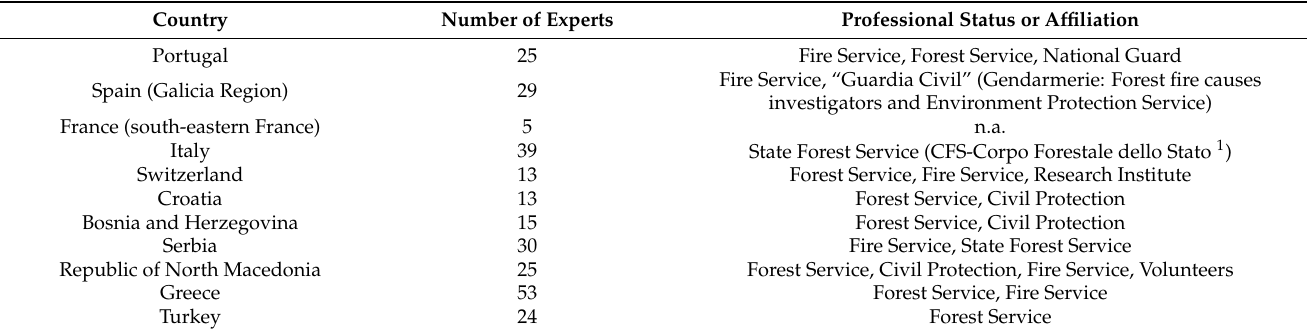
Table 1. Number of experts and their affiliation, per country.